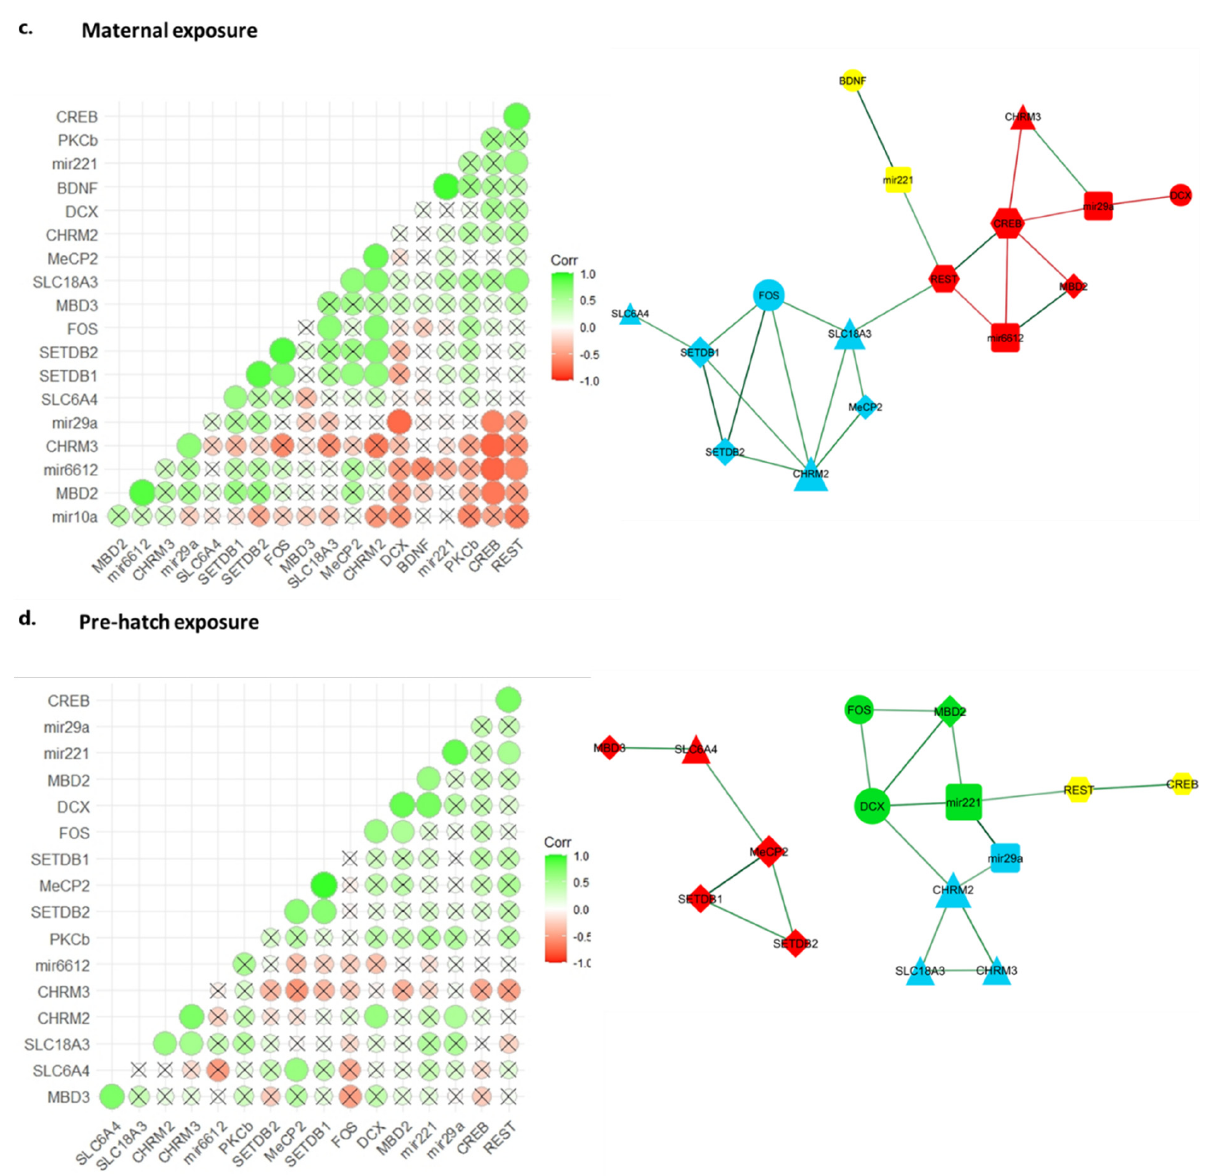
Figure 5. Gene co-expression correlation matrix and network in the offspring of the control ( a ), paternally ( b ), maternally ( c ), and pre-hatch ( d ) chlorpyrifos-exposed chickens. In the left panel, a correlation matrix between the different genes. Non-statistically significant correlations are marked in x. In the right panel, correlation networks between the genes represented as nodes and their correlation as edges. Node size represents the number of connecting edges of the network; only statistically significant correlations were considered. Detected modules (nodes communities) are stained with different colors. Module 1—red, Module 2—yellow, Module 3—light blue, Module 4—green and Module 5—purple. In both panels, edges and correlation color intensity signifies an increased correlation, with green for positive correlations and red for negative correlations.